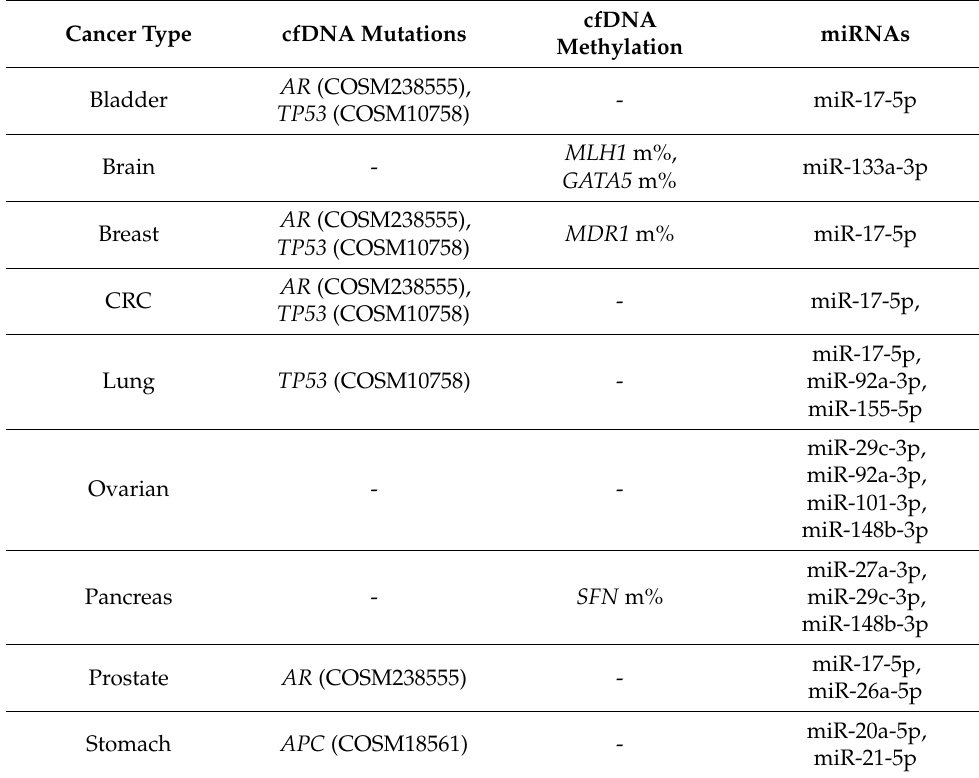
Table 2. Biomarkers with the highest correlations for each cancer